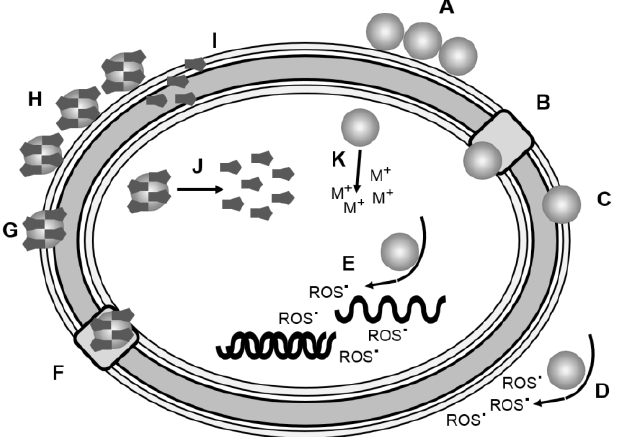
Figure 9. Mechanisms by which nanoparticles can exert an antimicrobial effect: ( A )Accumulation at the cell wall surface; ( B ) Penetration of the cell, either through damaged cell wall or ( C ) endocytosis; ( D ) Generation of reactive oxygen species externally or ( E ) internally; ( F ) Penetration of nanoparticle and drug payload through damaged cell wall or ( G ) endocytosis; ( H ) Accumulation of nanoparticle and drug payload on cell wall; ( I ) Release of drug payload externally or ( J ) internally; ( K ) Generation of toxic metal ionic species.